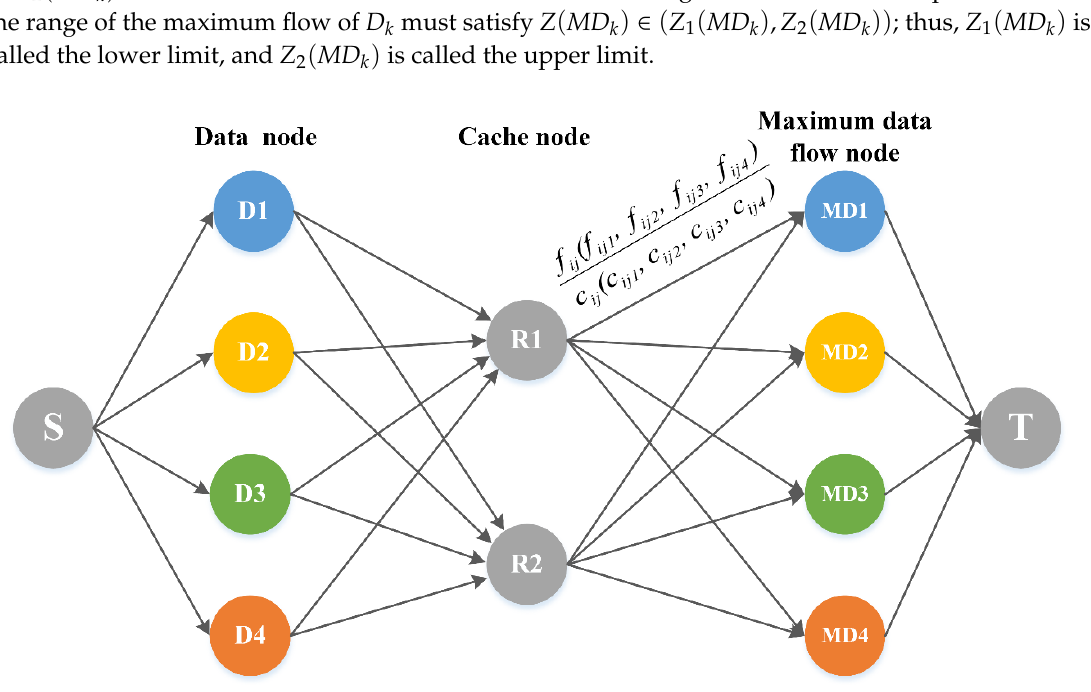
Figure 4. Maximum flow scheduling model with all requests hit.